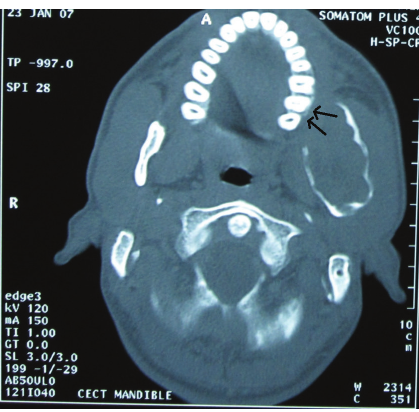
Figure 3: Transverse section of CT showing deflection of the left maxillary arch medially near the tuberosity.